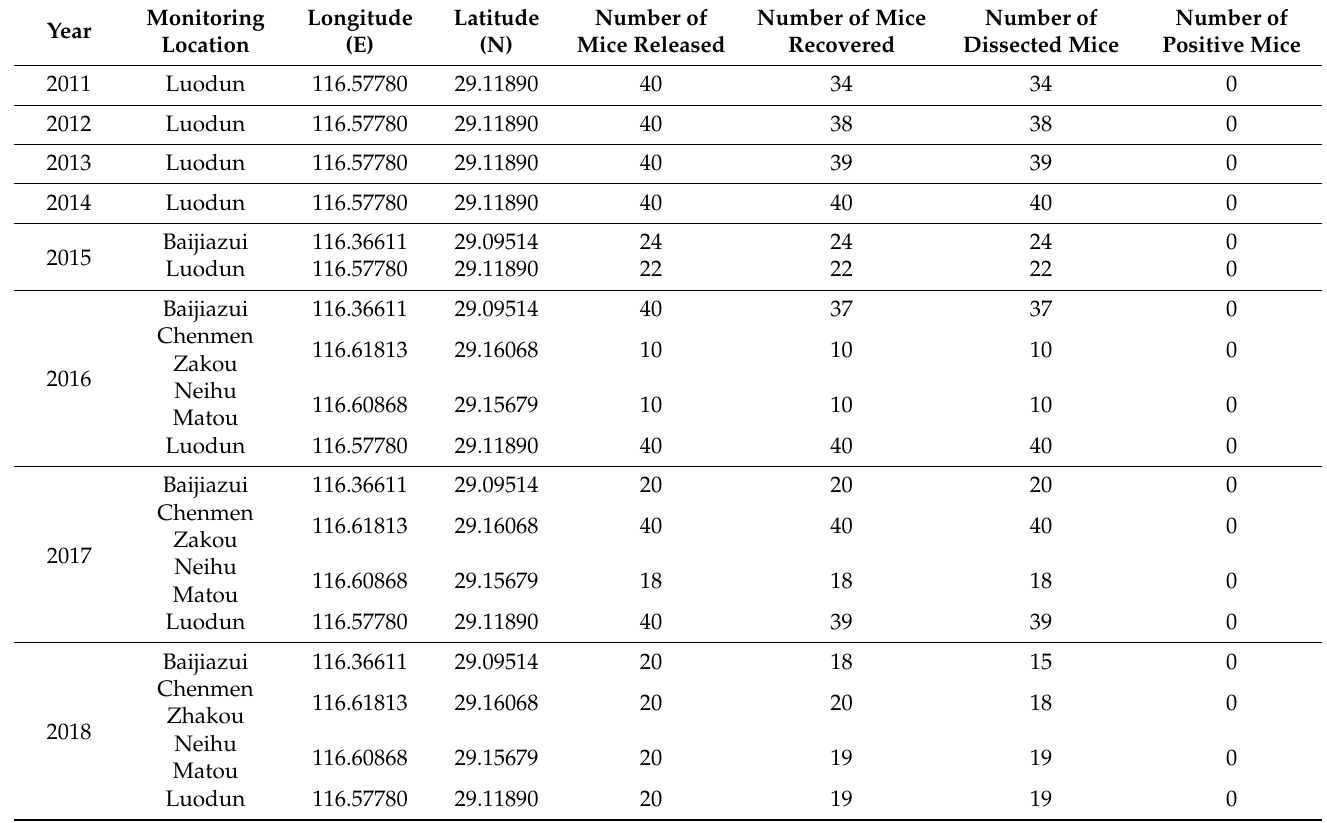
Table 3. Monitoring of schistosomiasis in wetland park